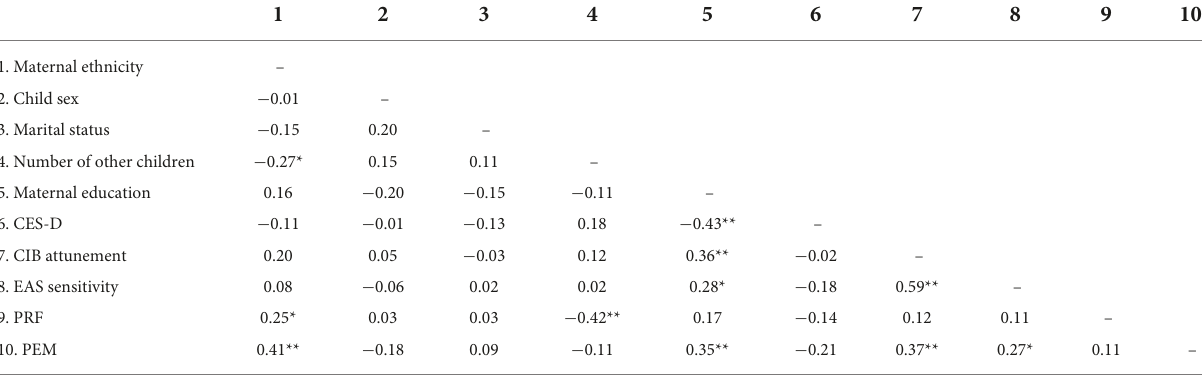
TABLE 2 Means, standard deviations, and zero-order correlations between background variables and research